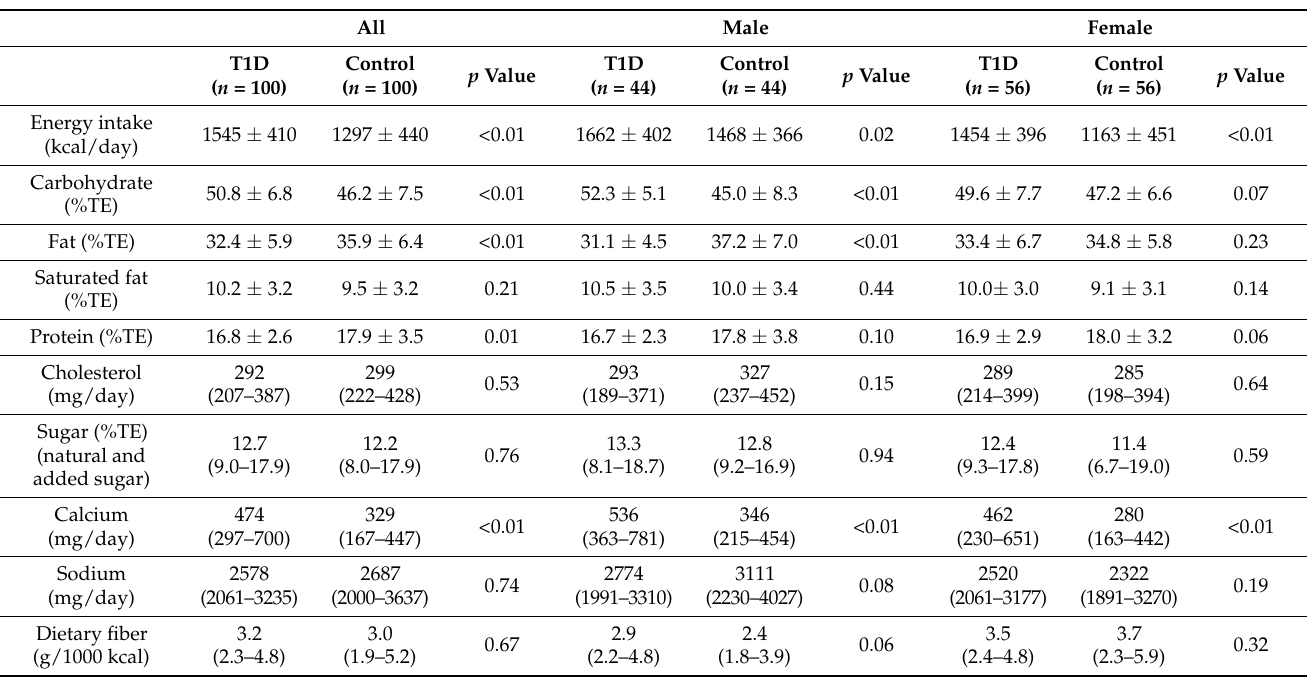
Table 3. Macronutrient and micronutrient intake per day compared between those with and with- out type 1 diabetes for the entire study population, for male study participants, and for female study participants.